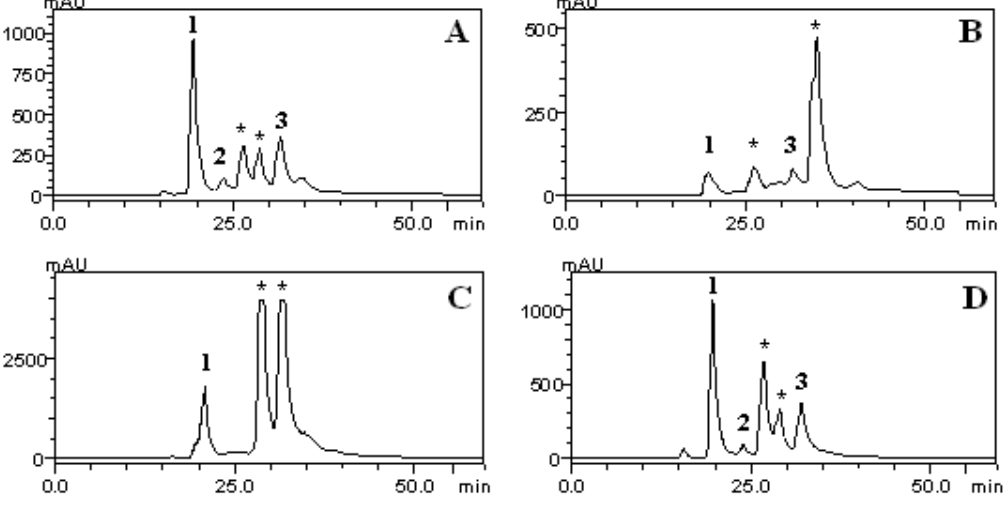
Figure 5. HPLC/DAD phenolics profile of CE ( A ), CHCl ( D ) fractions of S. guaraniticum leaves. (1) chlorogenic acid, (2) caffeic acid, (3) rosmarinic acid, ( * ) unknown